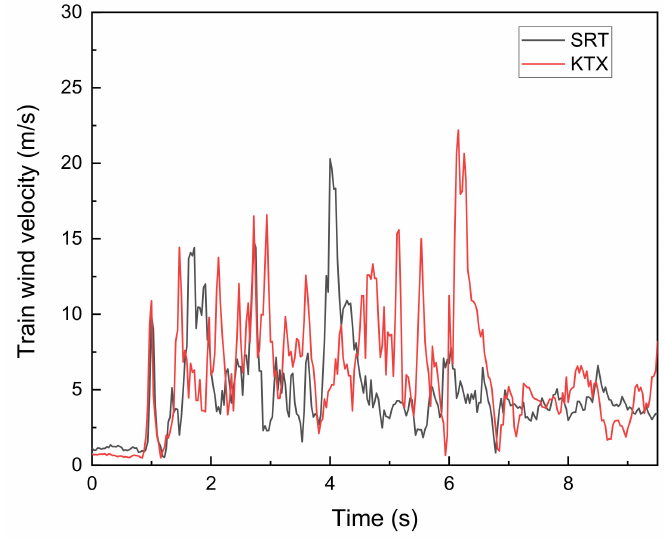
Figure 4. Train-induced wind velocity over time measured at a 0.8 m distance from the train